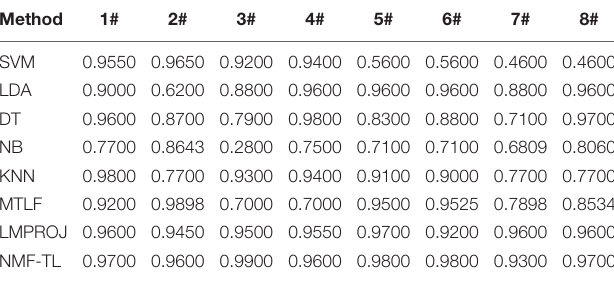
TABLE 8 | F1_score of 8 classifiers on datasets based on SIFT feature extraction.